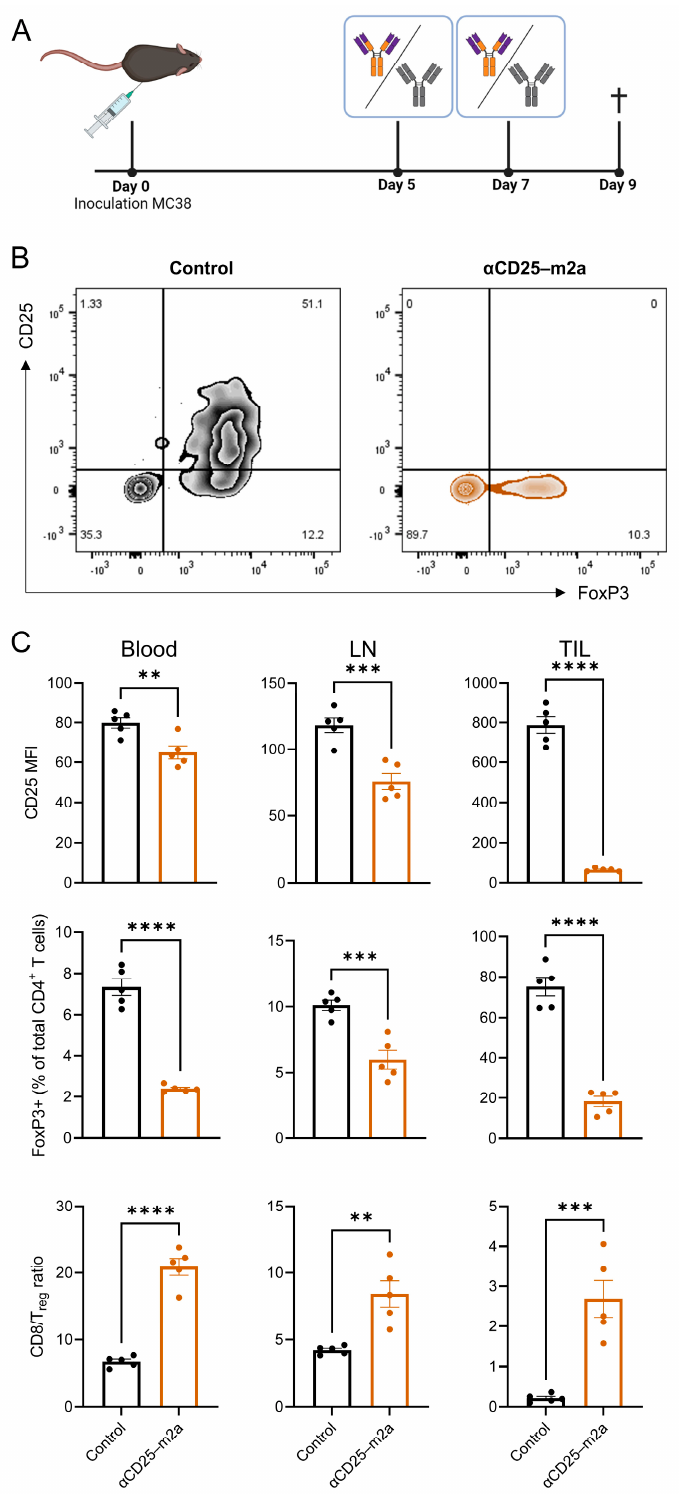
Figure 2. Effective depletion of T regs in blood, lymph nodes, and tumors via Fc-optimized α CD25- m2a. ( A ) Schematic of tumor challenge in C57/Bl6 mice. On day 0, mice were subcutaneously inoculated with MC38 and on days 5 and 7 were treated with either α CD25-m2a or an isotype control. Blood, lymph nodes, and tumors were harvested on day 9. ( B ) Representative plots showing expression of CD25 and FoxP3 in CD3 + CD4 + T cells isolated from tumors. Numbers show percentage of cells in each quadrant. ( C ) MFI of CD25 in T regs , percentage of T reg cells in CD3 + CD4 + T cells, and T eff /T reg cell ratios in blood, lymph nodes, and tumors ( n = 5, statistical difference determined via independent Student’s t -test: ** p ≤ 0.01; *** p ≤ 0.001; **** p < 0.0001).